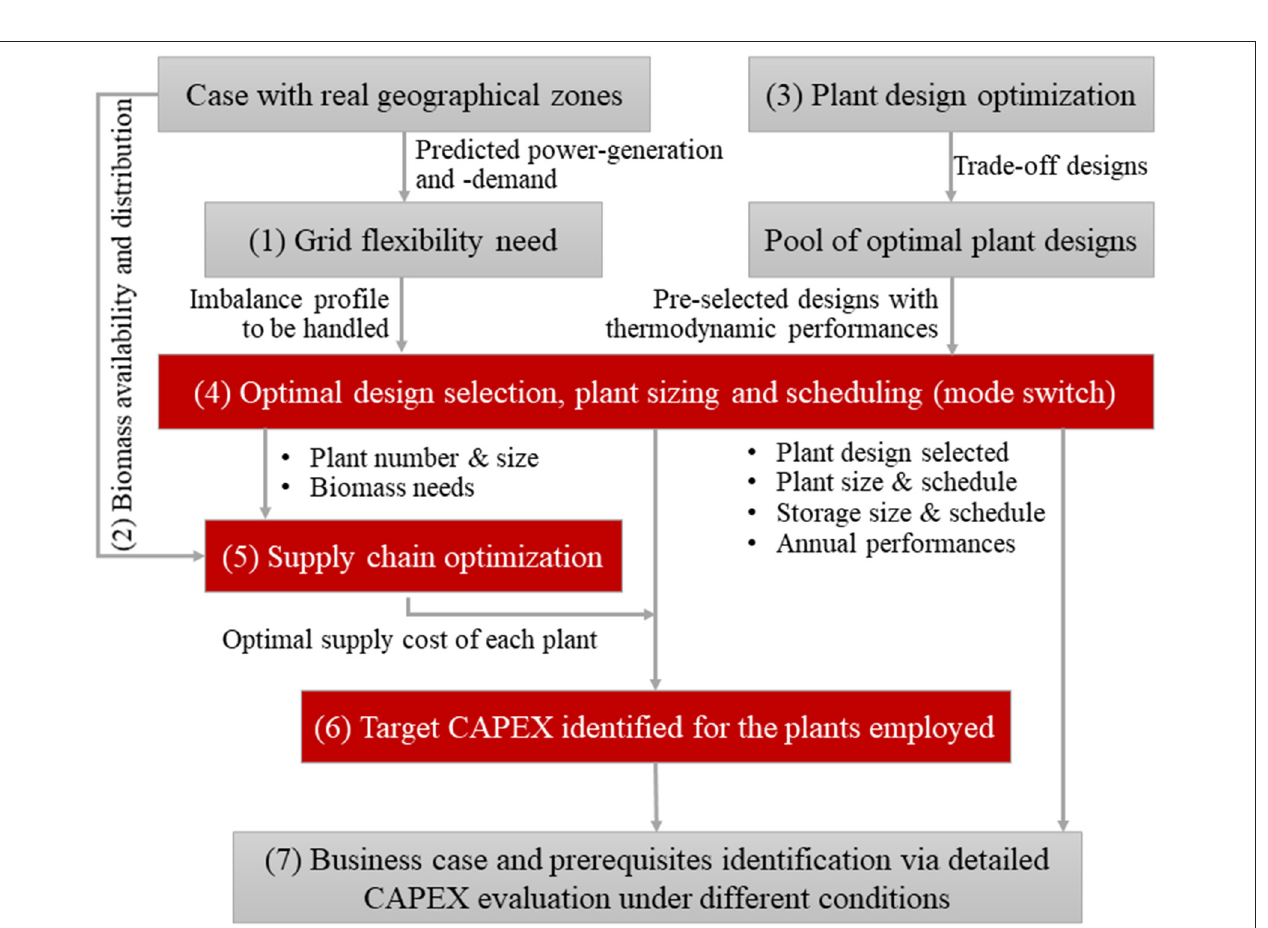
Frontiers in Energy Research |